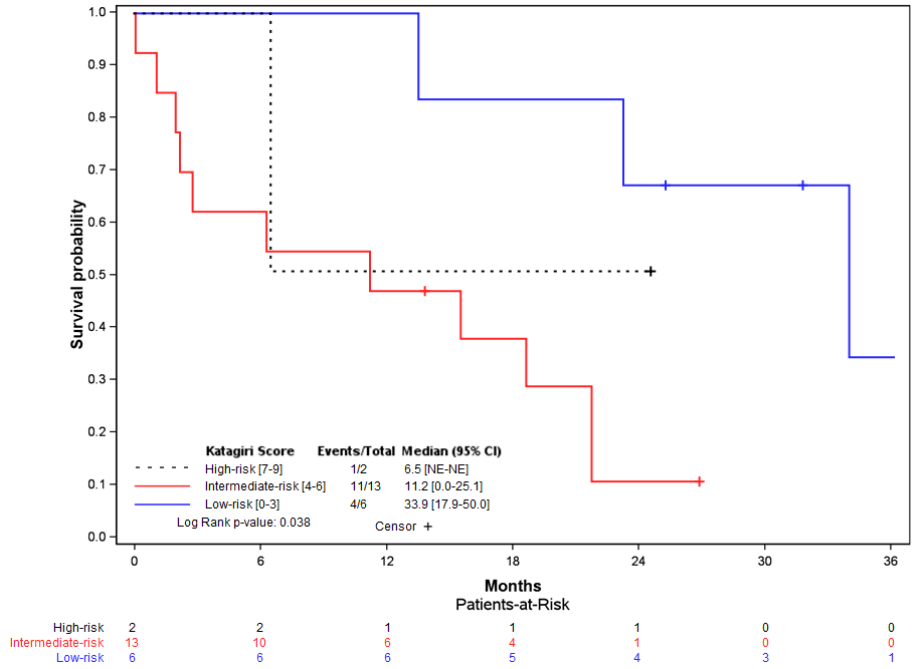
Figure 6. Kaplan–Meier curve for patient overall survival depending on the Katagiri risk score, with log-rank analysis ( p =